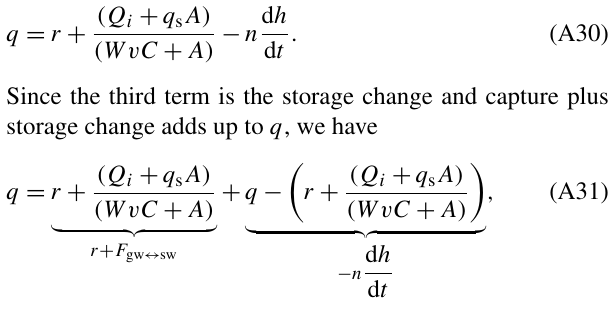
Figure A2. Water balance of a stream in case q > q crit and t > t crit (h(t) < d)